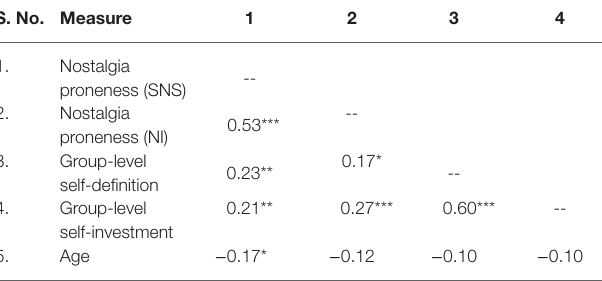
TABLE 2 | Correlations among nostalgia proneness, group-level self-definition, group-level investment, and age in Study